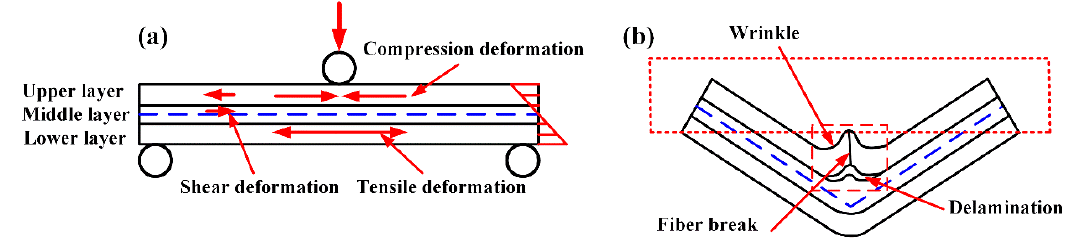
Figure 14. Schematic of flexural failure mechanism of woven CF / PEEK composites: ( a ) force schematic, and ( b ) failure schematic.